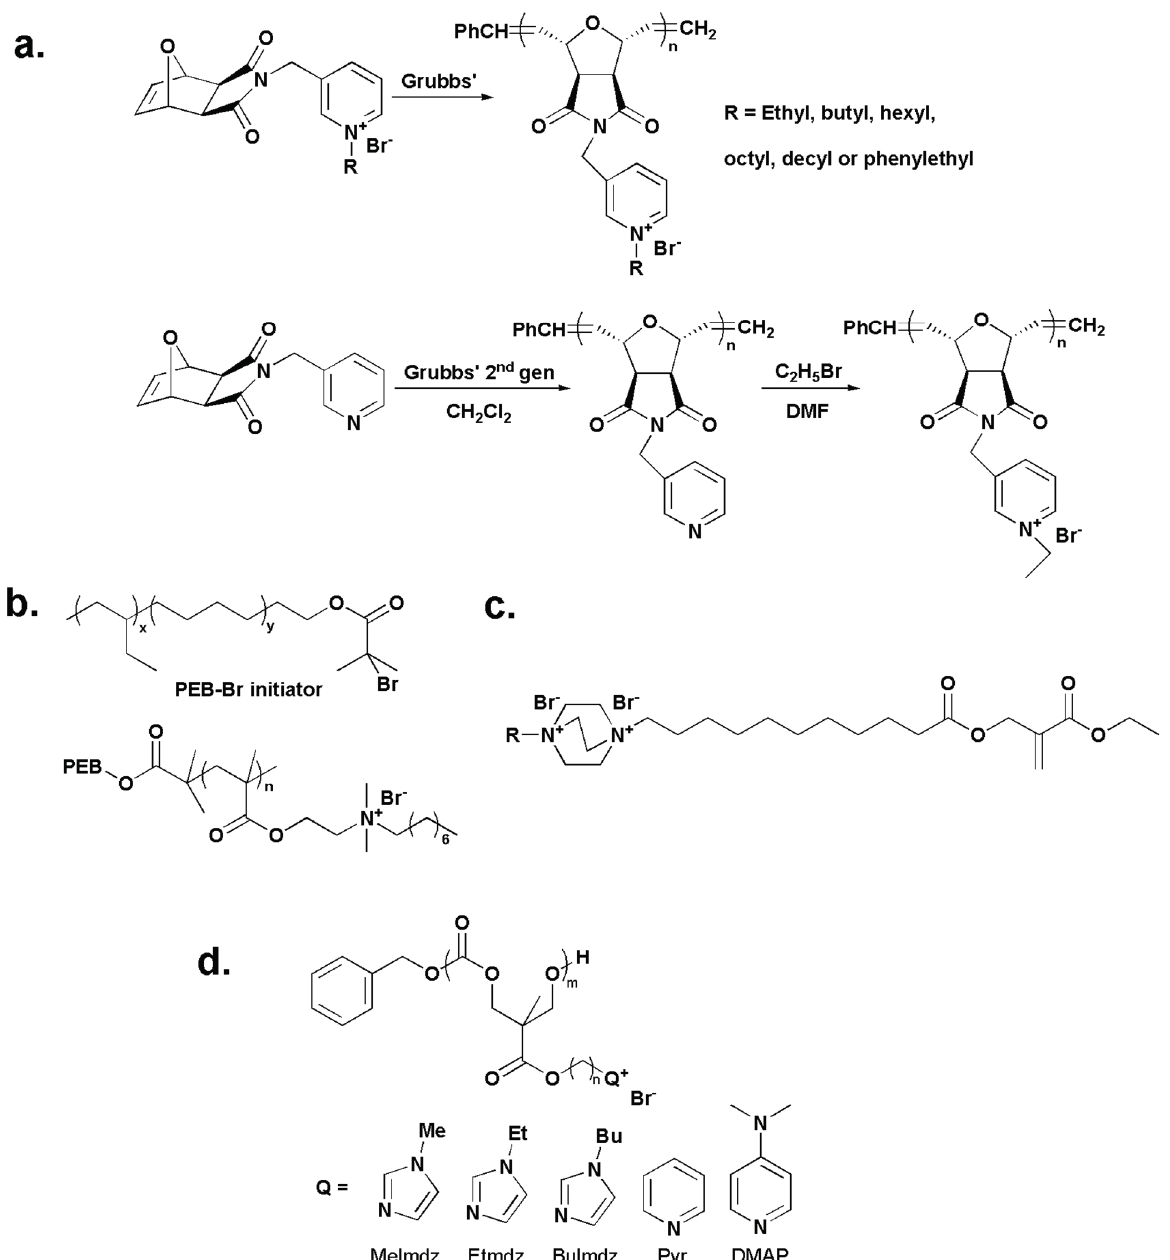
Figure 1. ( a ) Two synthetic pathways for polymers based on oxanorbornene derivatives, adapted with permission from [32]; ( b ) Octyl bromide quaternized poly(ethylene- co -butylene)- b -poly[2-(dimethylamino)ethyl-methacrylate] (PEB- b -PDMAEMA), adapted with permission from [33]; ( c ) Bis-quaternary ammonium methacrylate monomer based on 1,4-di-azabicyclo-[2.2.2]-octane, adapted with permission from [34]; ( d ) Antimicrobial polycarbonates with quaternized nitrogen-containing heterocycles, adapted with permission from